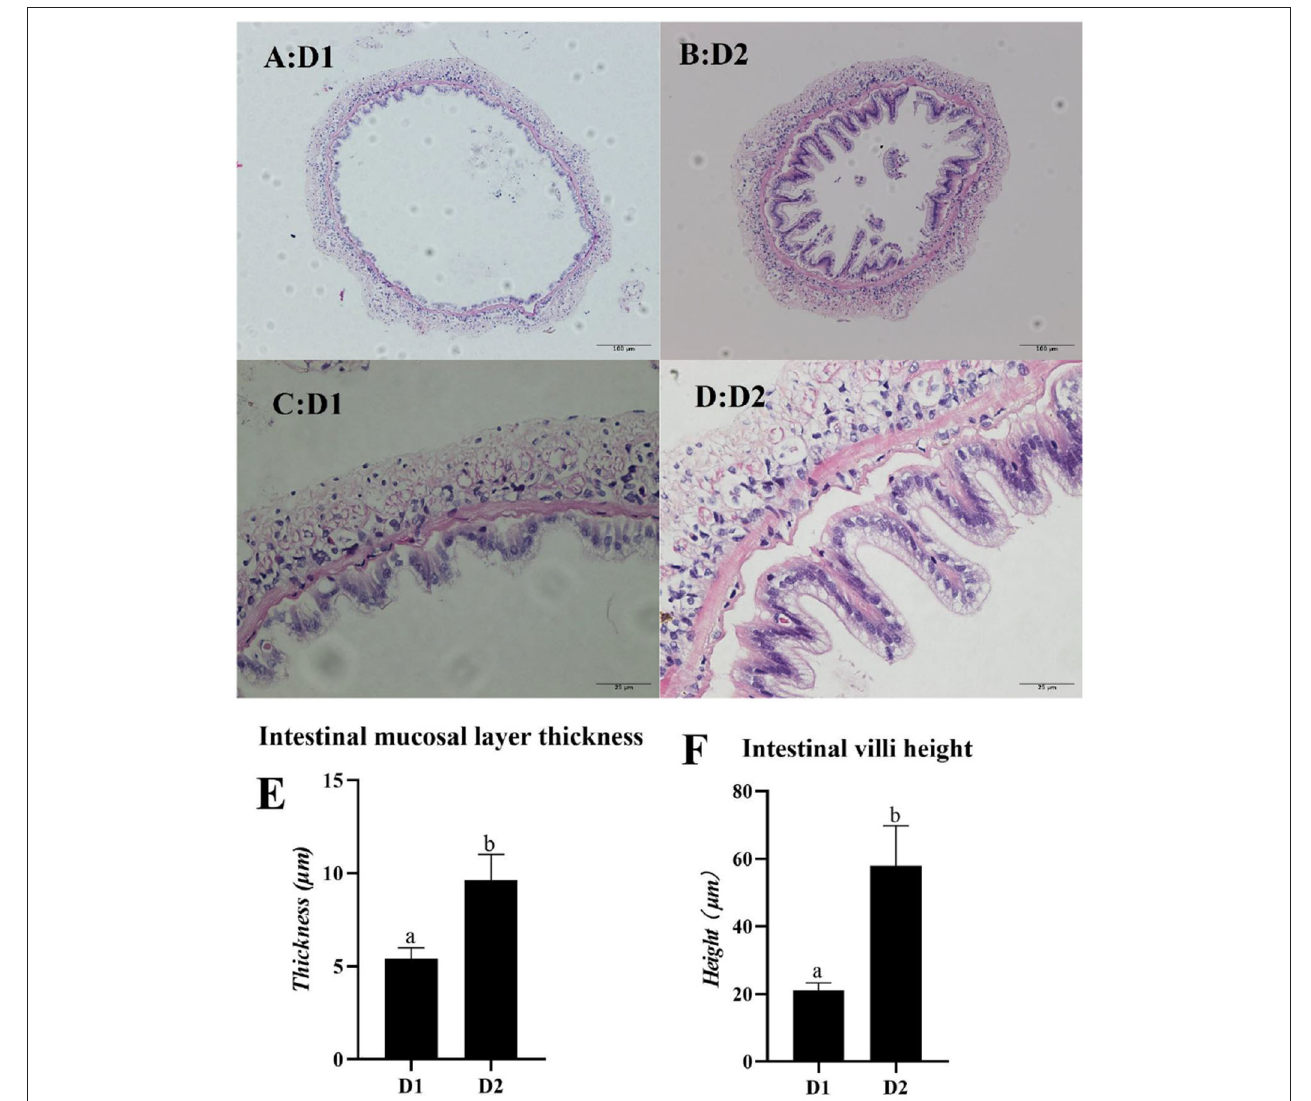
FIGURE 4 | Light microscopy of mid-intestine morphology of L. vannamei fed diets supplemented with/without Klebsormidium sp. for 56 days. Scale bars (A,B) = 100 µ m; Scale bars (C,D) = 25 µ m. (E,F) represent the mid-intestinal mucosal layer thickness and intestinal villi height of L. vannamei . a , b The small letters indicated significant differences at p <